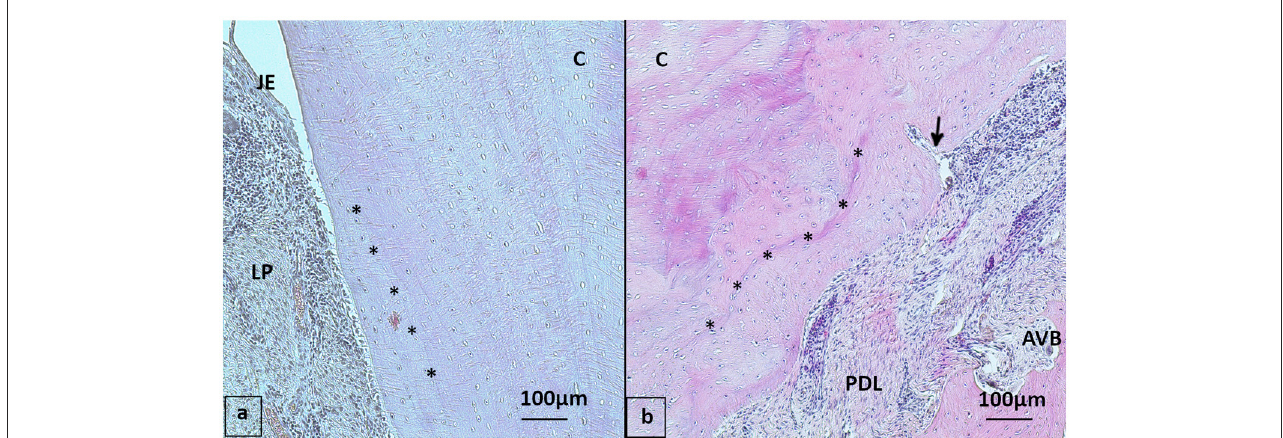
FIGURE7 Cemental structure, HE stained (a) 20-year-old Icelanic mare from the control group, buccal aspect of 409 with regular cemental structure (asterisk: incremental lines of Salter almost parallel to each other and to the cemental surface). (b) 30-year-old Pony gelding from the PPID group, 109 buccal aspect with “irregular” cementum: Multiple signs of reparative cementum and incremental lines of Salter not parallel to each other (asterisk), note the blood vessel (arrow) running into the cementum. JE, Junctional epithelium; LP, Lamina propria; PDL, Periodontal ligament; AVB, Alveolar bone; C,